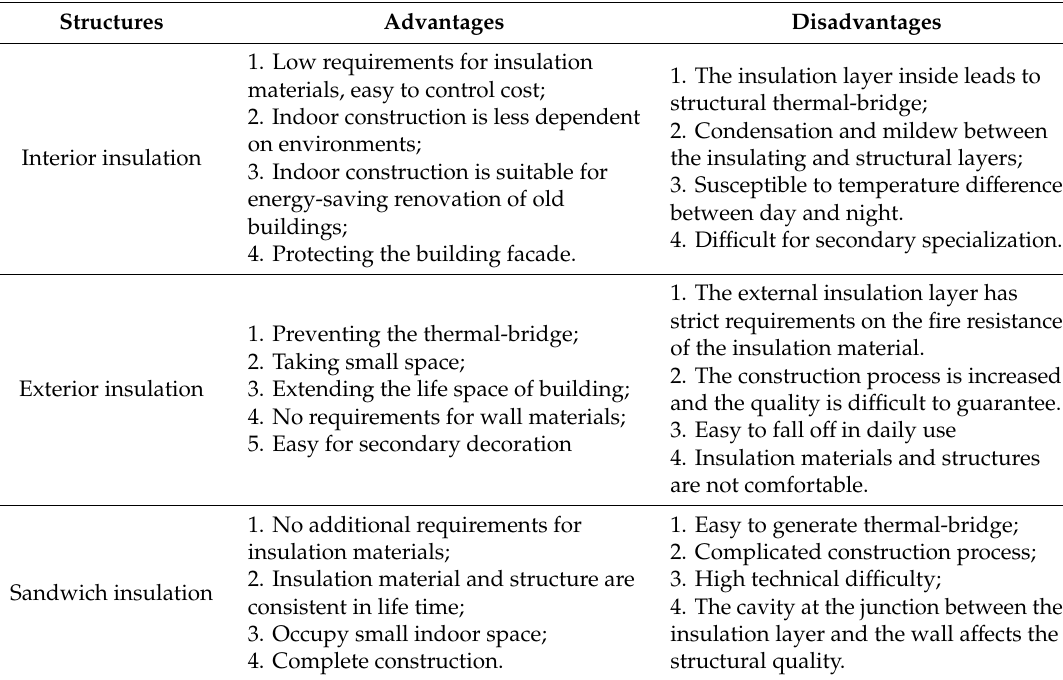
Figure 4. Schematic diagram of the passive house structure. Table 4. Characteristics of three thermal insulation structures.